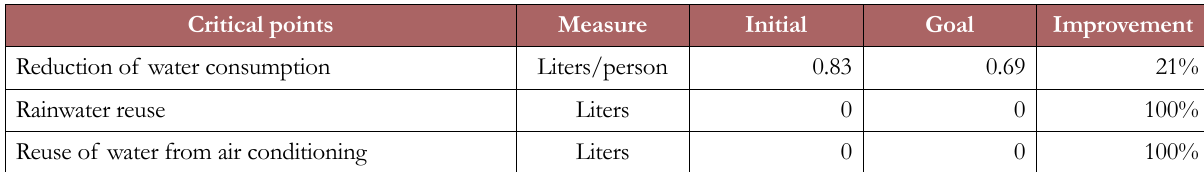
Table 5. Alpha water consumption reduction